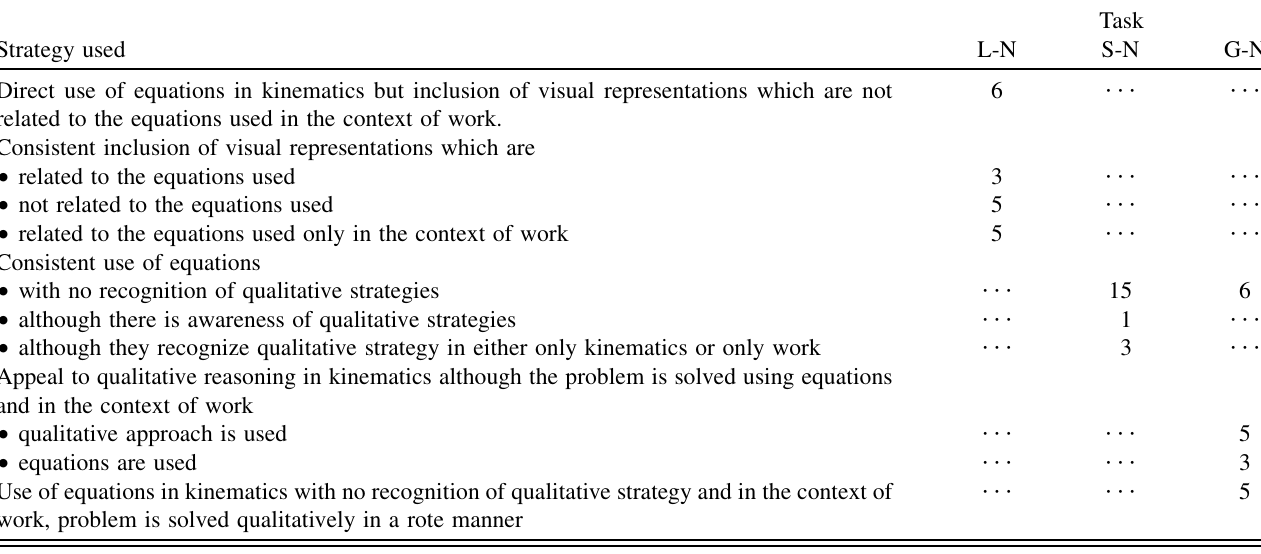
TABLE XII. Strategy used by the same student when generating mathematical formulation from task posed in linguistic, symbolic, and graphical representations across the two